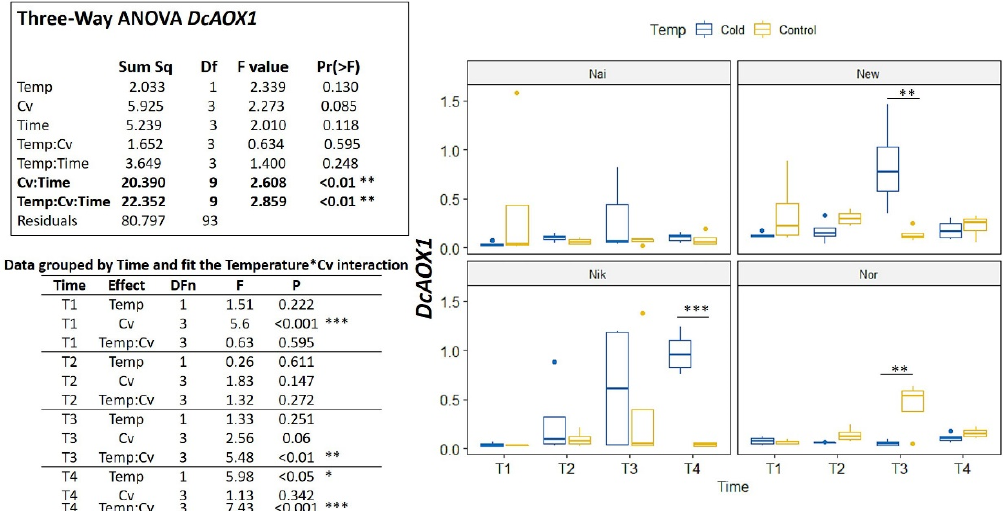
Figure 5. Expression box-plot and three-way ANOVA analysis for DcAOX1 during cold challenge (T1: 4 h, T2: 8 h, T3: 24 h, and T4: 7 days) in carrot cultivars (Cv) ’Nairobi’ (Nai), ‘Newcastle’ (New) ‘Nikki’ (Nik), and ‘Norwich’ (Nor). Transcript levels were determined by RT-qPCR. For each time point, four biological replicates were considered per temperature. Significant differences between temperatures for the same time point are indicated by * ( p < 0.05), ** ( p < 0.01) or *** ( p < 0.001). Boxplots show the distributions (median, spread and outliers) of the gene expression values.